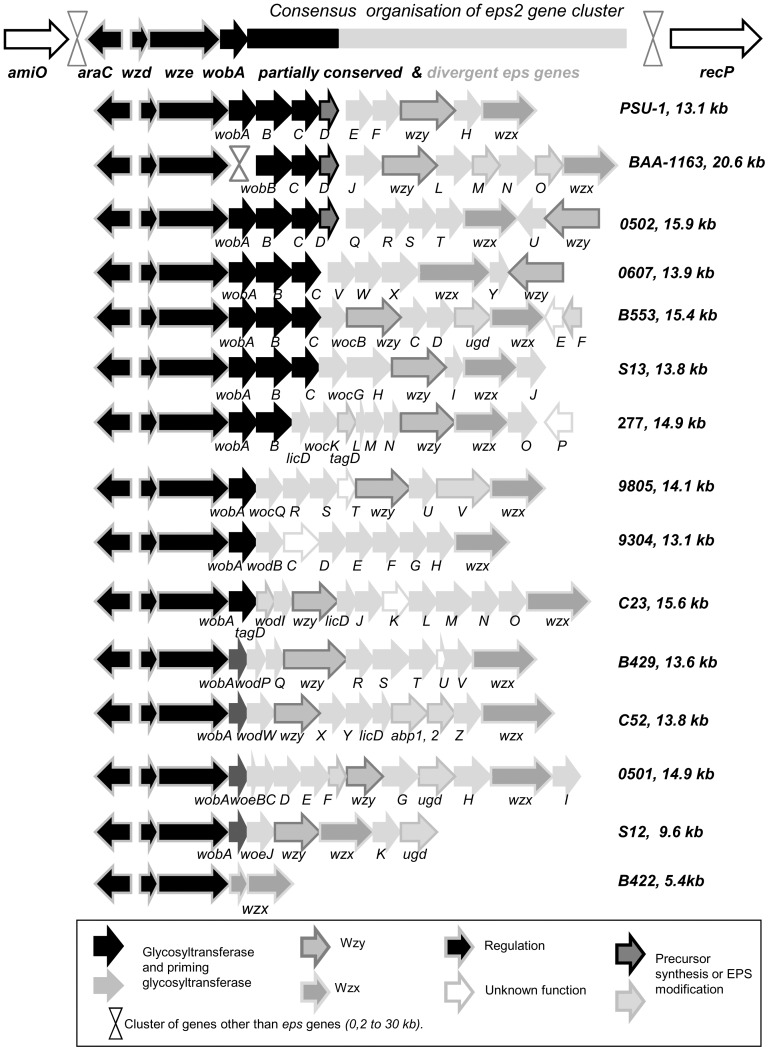
Comparison of the eps 2 gene clusters.In front of each model of cluster eps2, the name of the model strain and the size of the cluster are indicated. When present, the eps2 cluster is always located between recP and amiO (core genome genes in O. oeni chromosome). It displays, in its 5′ end, the three genes araC, wzd and wze, the initial transferase gene wobA (3 different versions), and then, genes specific to each model. The arrows filling indicate the putative function of the encoded proteins. The black and dark gray fillings indicate genes shared by several models of eps2. On the other hand, light gray arrows indicate genes specific to a single model. Groups of strains bearing the same eps2 cluster: Model PSU-1:
 B418,
Model 0502:
 B10,
Model 0607:
 L26_1, S22, S25,
Model B553:
 L65_2, 9517
Model 277:
 S15, S161, L18_3, 450, S14,
Model

9805
∶9803, 8417,
Model 9304
: C28,
Model B429:
 B202, B304 B318, B568, B576, 0608, CiNe, S11, S23, S28,
model B422
: B548, 0205, B16.
No eps2
: VF, S19, 1491, B129, L40_4, 436a, B419.